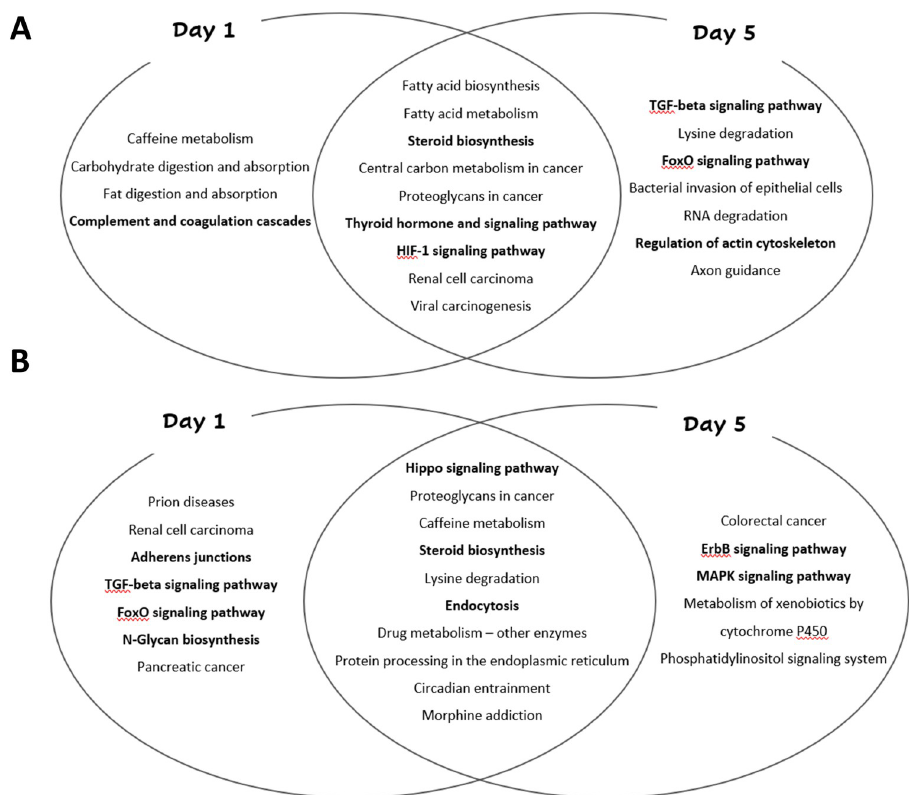
Fig 4. (A). Analysis of significant union pathways overlapping, and non-overlapping. Venn diagram representing the signaling pathways overlapping, and non-overlapping refer to the miRNAs with an increased expression on days 1 and 5. (B). Analysis of significant union pathways overlapping, and non-overlapping. Venn diagram representing the signaling pathways overlapping, and non-overlapping refer to the miRNAs with a decreased expression on days 1 and